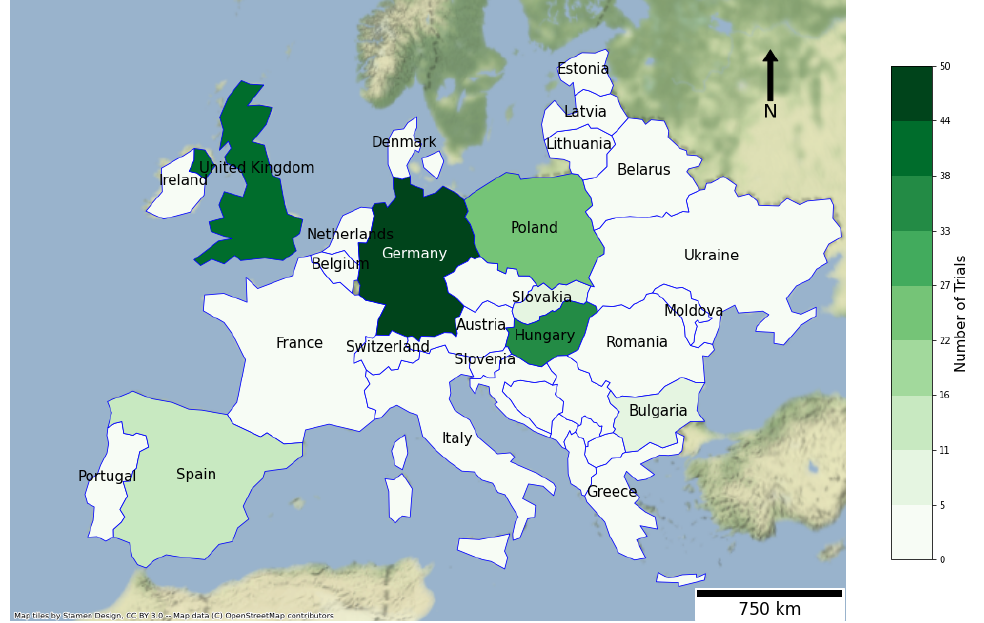
Figure 2. A Choropleth plot representing the distribution of all the field trials taken within Europe that were used in this